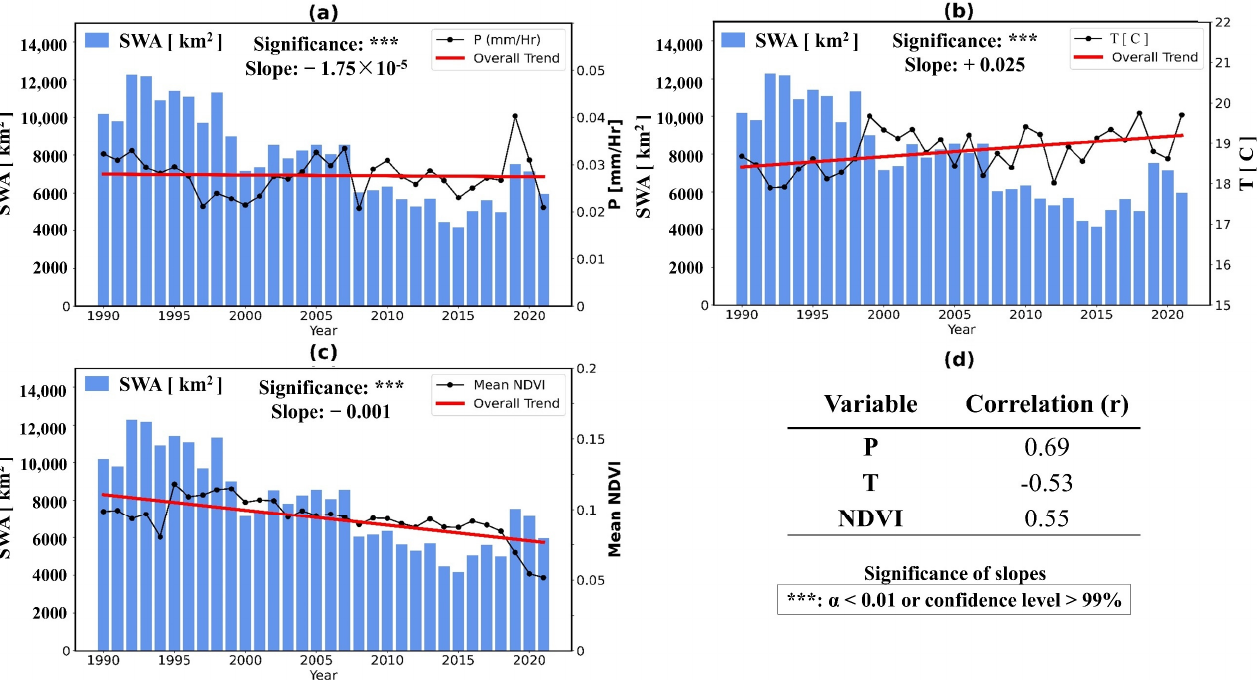
Figure 11. Long-term comparison of SWA against environmental variables (from FLDAS): ( a ) an- nual mean precipitation rate (P), ( b ) annual mean temperature (T), ( c ) annual mean NDVI, and ( d ) correlation analysis between SWA and P, T, and NDVI.